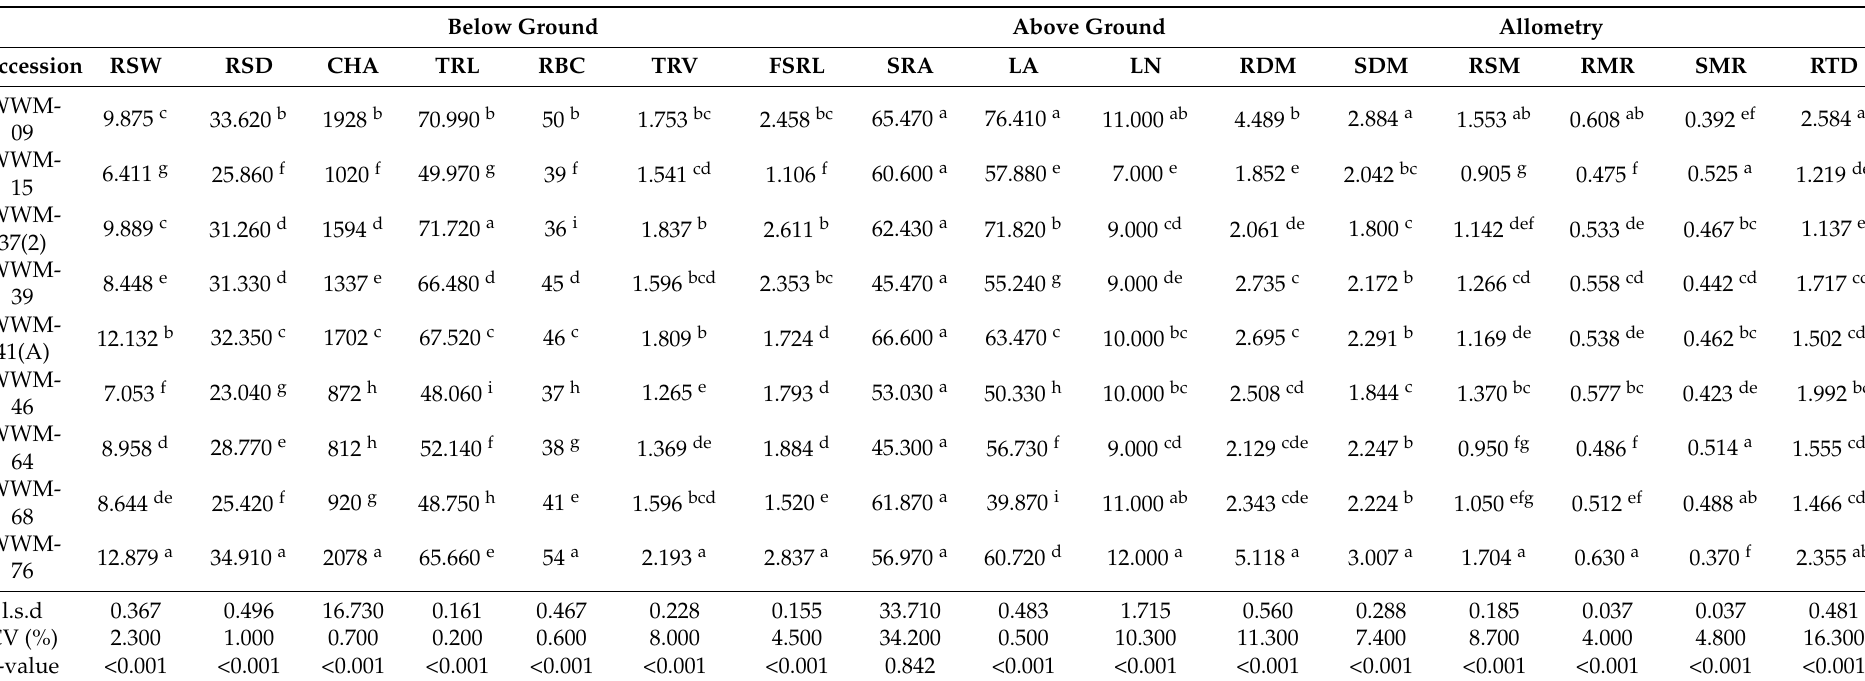
Table 4. Mean values for root and leaf traits of nine citron watermelon accessions evaluated in rhizotrons under non-stressed conditions 35 days after planting. Below Ground Above Ground